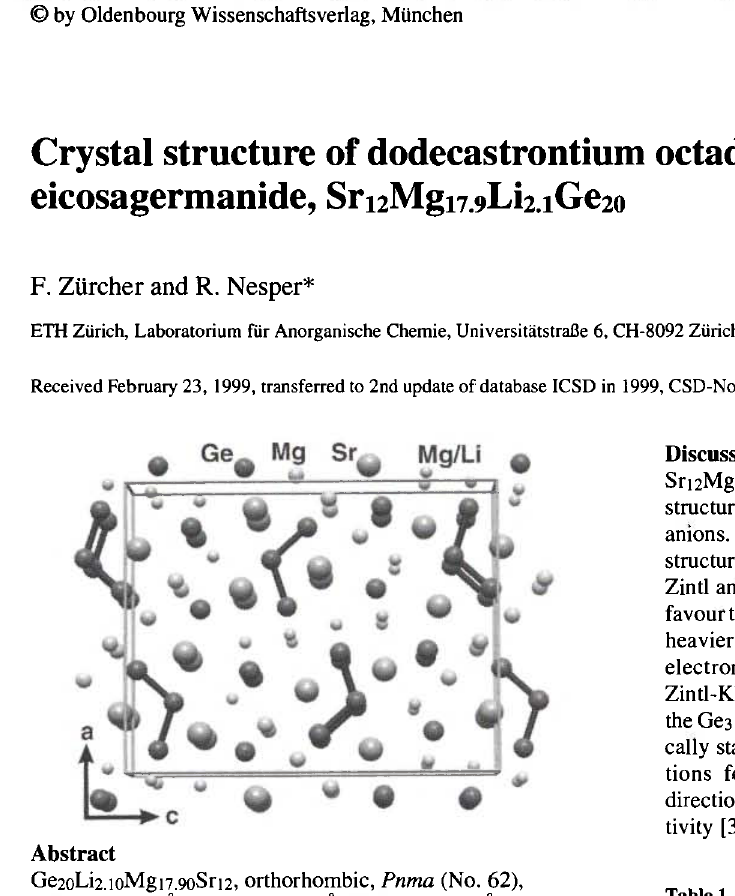
Table 1. Data collection and handling.